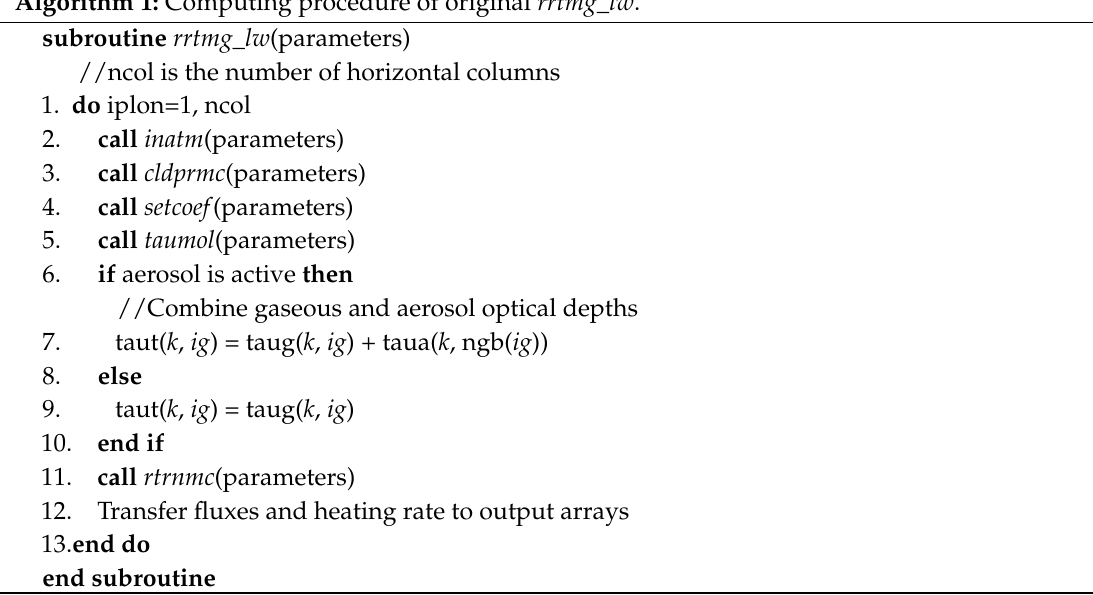
Figure 1. Profiling graph of the original rapid radiative transfer model for general circulation models (RRTMG) long-wave radiation scheme (RRTMG_LW) code in the Chinese Academy of Sciences–Earth System Model (CAS–ESM): Here, each arrow represents the invoking relation among subroutines. Algorithm 1: Computing procedure of original rrtmg_lw